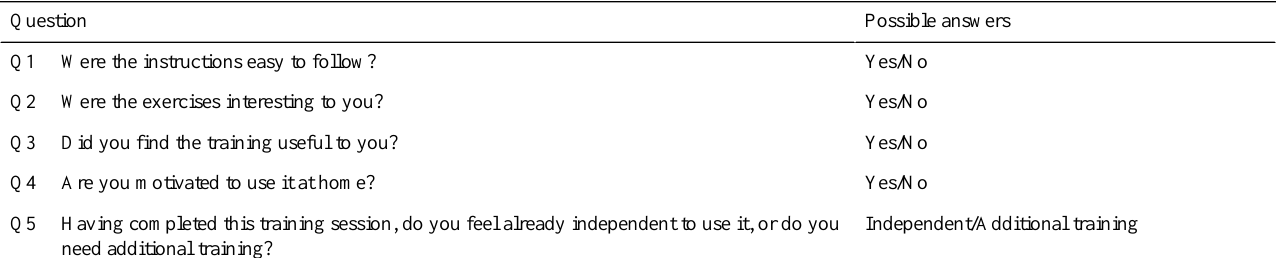
Table 2. Opinion